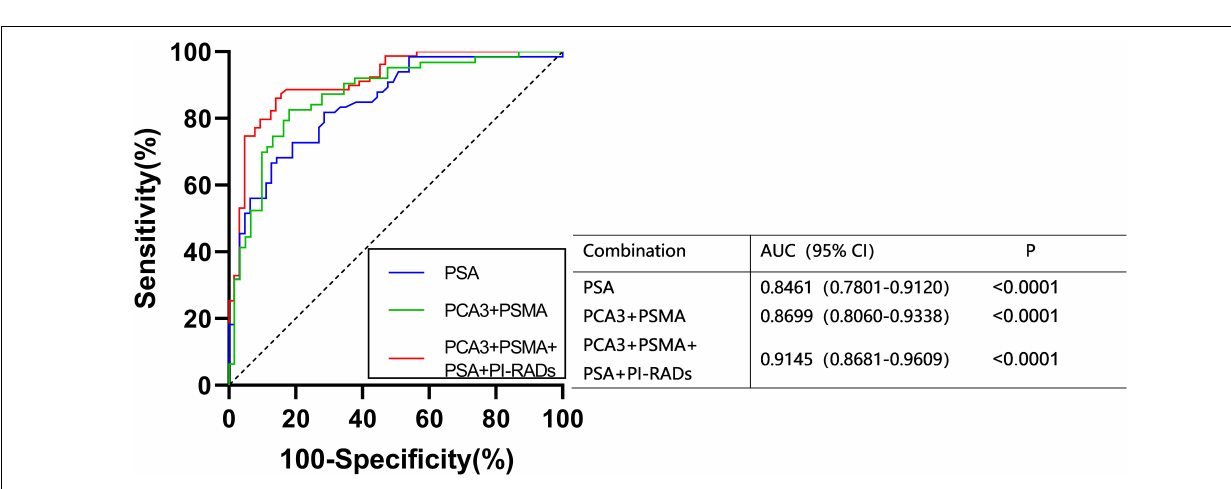
FIGURE 4 | ROC curves were calculated for the combined PCA3, PSMA, PI-RADS, and PSA using logistic regression